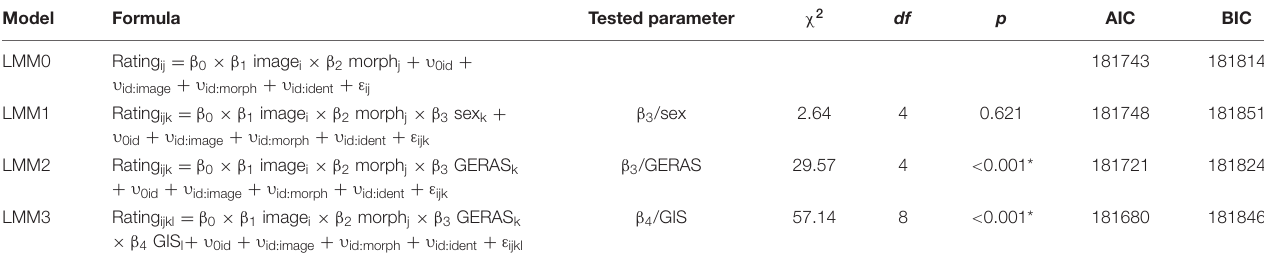
TABLE 4 | Relationship between perceiver attributes and rating. Model Formula Tested parameter χ 2 df AIC BIC